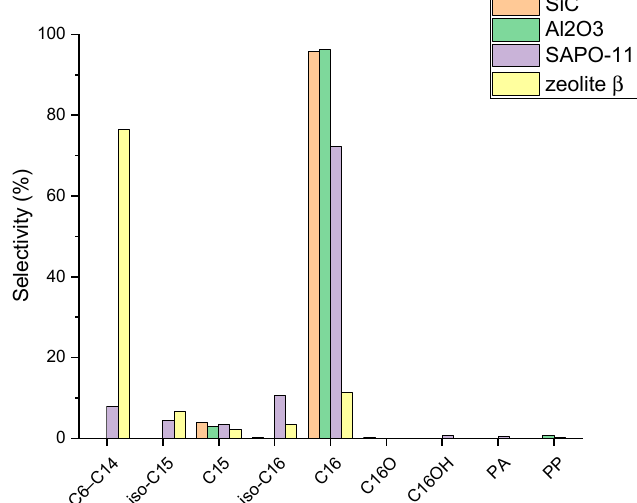
Figure 4. MP and O conversion in MP HDO over MoP / SiO 2 catalyst diluted with di ff erent materials. V cat = 0.4 cm 3 , LHSV = 60 h − 1 , T = 290 ◦ C, P H2 = 3 MPa, H 2 / feed = 600 cm 3 / cm 3 .